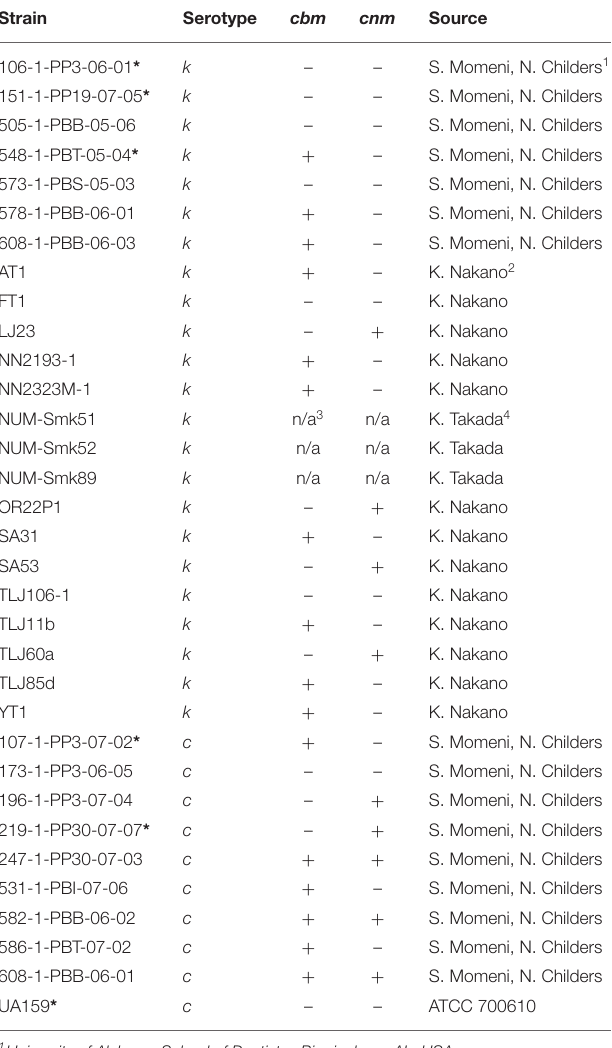
TABLE 1 | Streptococcus mutans serotype k ( n = 23) and c ( n = 10) strains. Strain Serotype cbm cnm Source 106-1-PP3-06-01 *